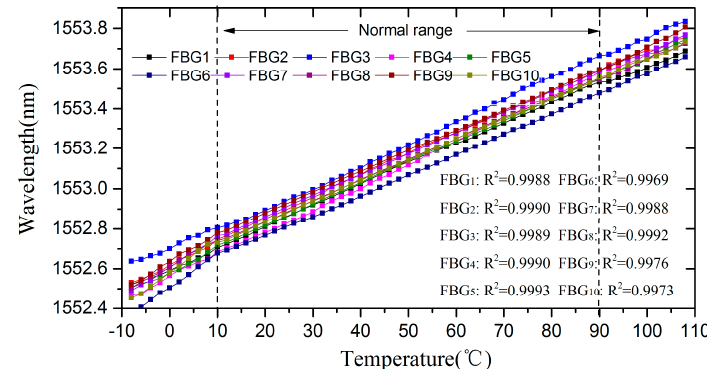
Figure 9. Monitor wavelength shift sensing character of the FBGs in temperature measurement.